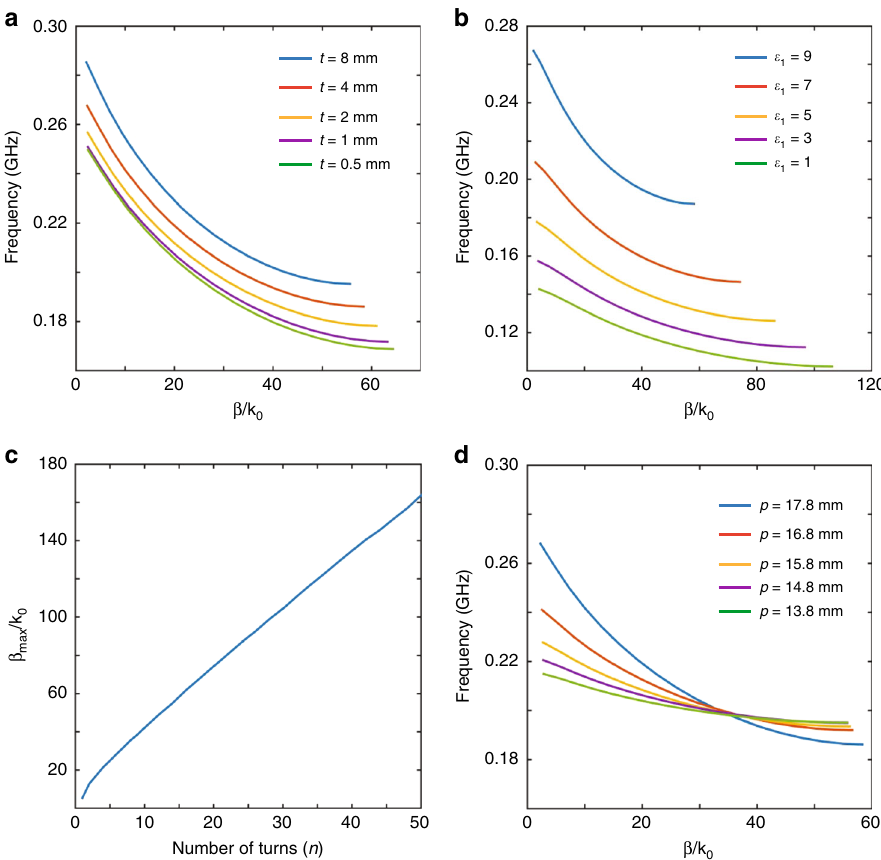
Fig. 3 Dependence of designer polaritons on metasurface parameters. a Dispersions of the metasurfaces with different substrate thicknesses. b Dispersions of the metasurfaces with different substrate permittivity. c Maximum squeezing factor as a function of numbers of turns. Here, we alter the numbers of turns while maintaining the other parameters (except the period) the same. Therefore, the period becomes longer as the number of turns increases. d Dispersions of the metasurfaces with different periods. The coils keep the same and the distance between neighbor coils